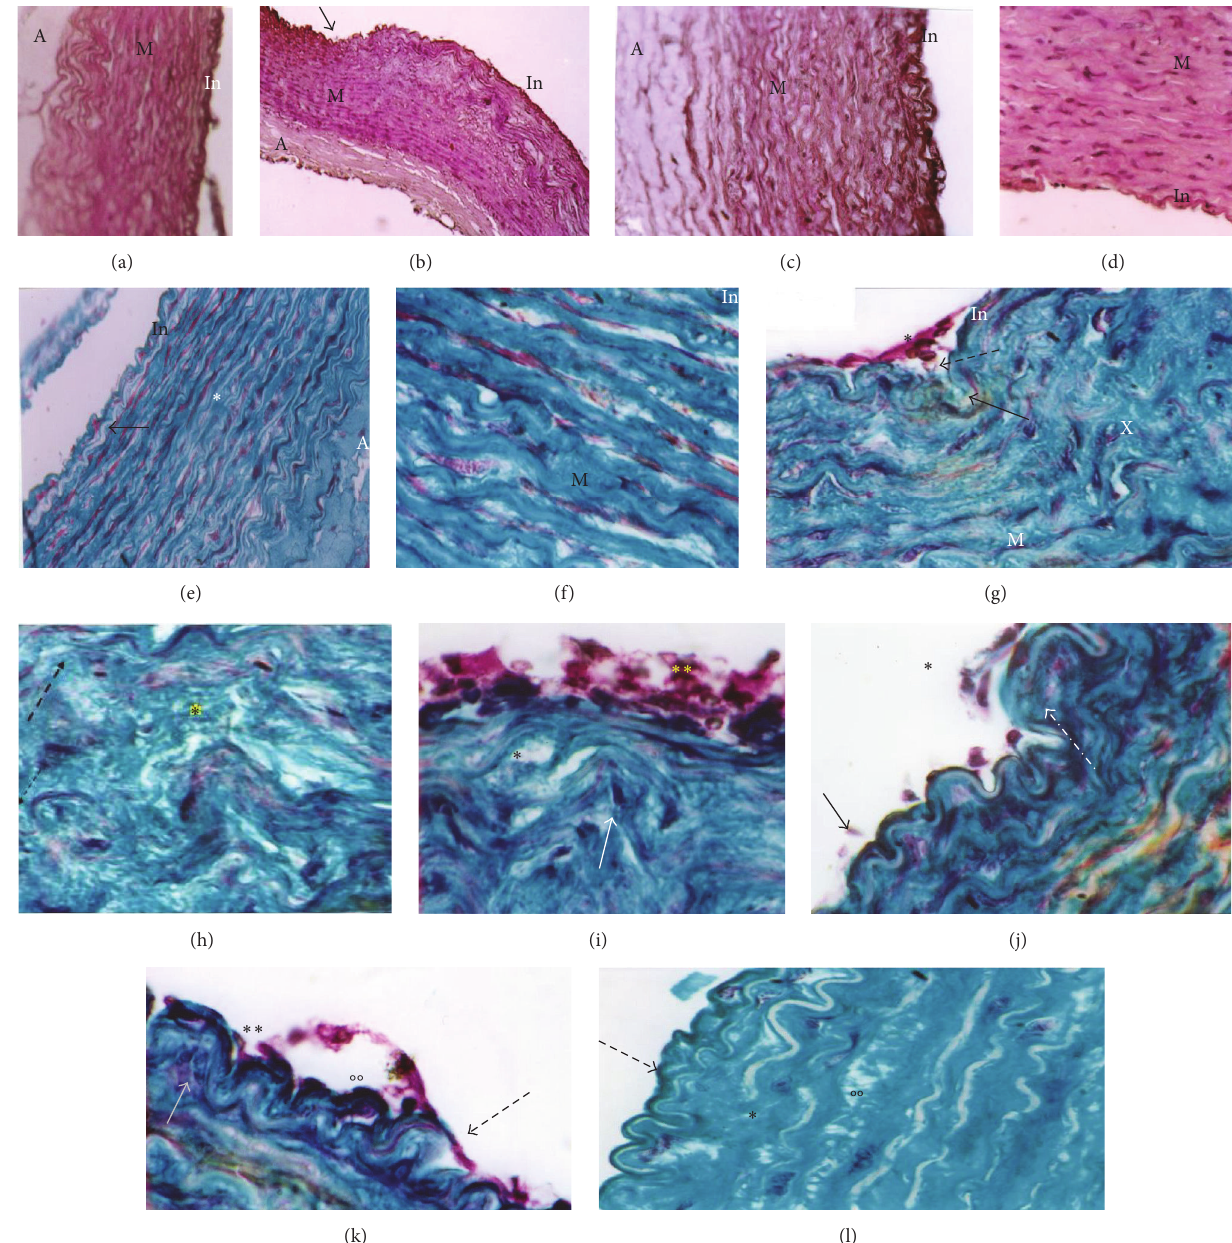
Figure 4: Aorta histology of the different groups of female rabbits. (a) NPC, (b) NPMet ( × 10 magnification), (c) PC, (d) PMet ( × 40) PAS staining; NPC × 40 (e); × 100 (f); NP Met × 100 (g, h, i, j, k, l) Masson’s Trichrome staining. M: media; A: adventitia; In: intima. While control aorta shows regular elastic strips with regular intimal border (a, e, f), aorta of NPMet shows intimal thickening (b) and invagination areas, increasing contact surface. In (g, h), the SMCs appear in concentric organization and oriented towards the vascular lumen. We observe a complete disorganization of media elements, fragmented elastic strips, high ratio MEC/cells ( ∗ ), foam cells in media turbulence areas ( ∗ ), and occurrence of noncollagen material and thrombus ( ∗∗ ) (h, i). Intimal infiltration of SMCs, blood elements aggregation against endothelium ( ∗∗ ), internal elastic lamina fracture, hypertrophy of endothelial cells (dark kernels) ( ∘∘ ), duplication of internal elastic lamina, amorphous refractive material accumulation ( ∘∘ ), and endothelial cells hypertrophy (fingernail) characterize the aorta of